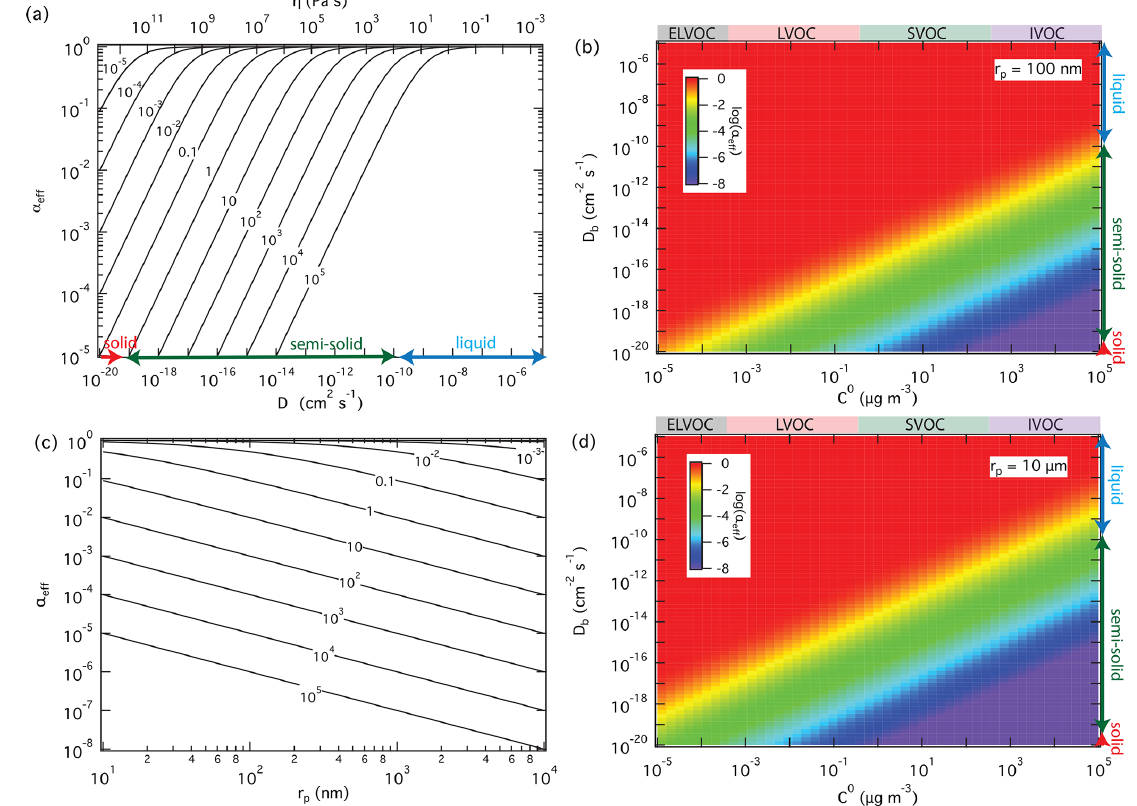
Figure 3. Effective mass accommodation coefficients, α eff , for non-reactive partitioning of organic compounds Z ( α s = 1, ω = 2 × 10 4 cms − 1 ) with liquid, semi-solid, or solid aerosol particles ( ρ p = 1gcm − 3 ) depending on pure compound volatility, C 0 , particle bulk diffusivity, D b (corresponding to viscosity, η ), and particle radius, r p . α eff calculated as a function of D b for C 0 = 10 − 5 to 10 5 µgm − 3 with r p = 100nm (a) ; α eff calculated as a function of C 0 and D b with r p = 100nm (b) and 10µm (d) ; α eff calculated as a function of particle radius for D b = 10 − 15 cm 2 s − 1 and different levels of volatility ( C 0 = 10 − 3 to 10 5 µgm − 3 ) (c)